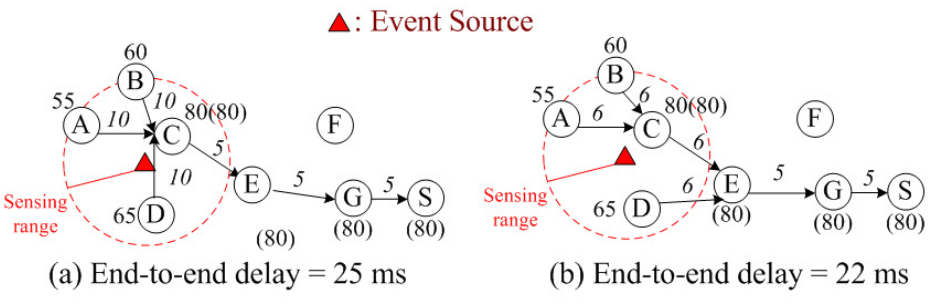
Figure 1. Data aggregation in